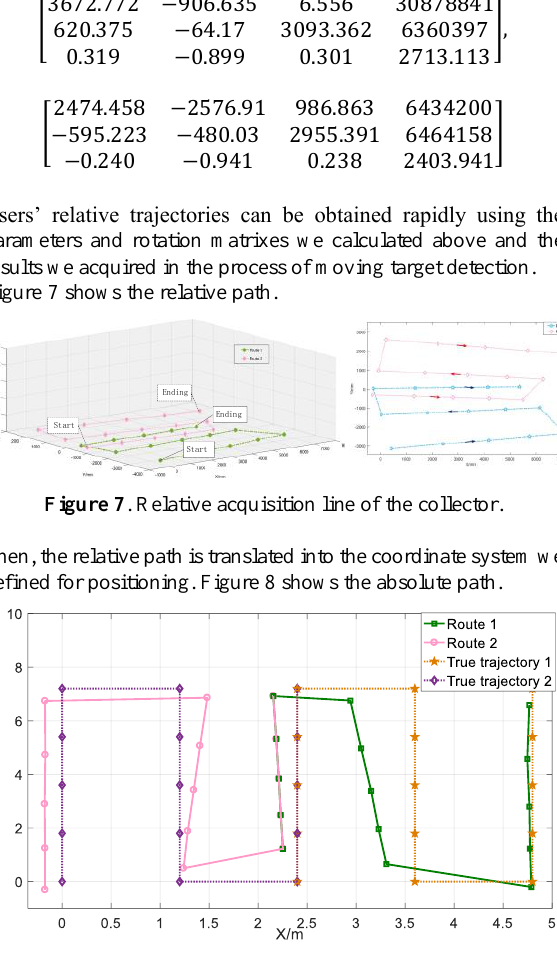
Figure 8 . True trajectory and the calculated path.